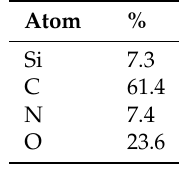
Table 2. Functional groups present in the PolyCat-Si obtained by the deconvolution of XPS spectra.